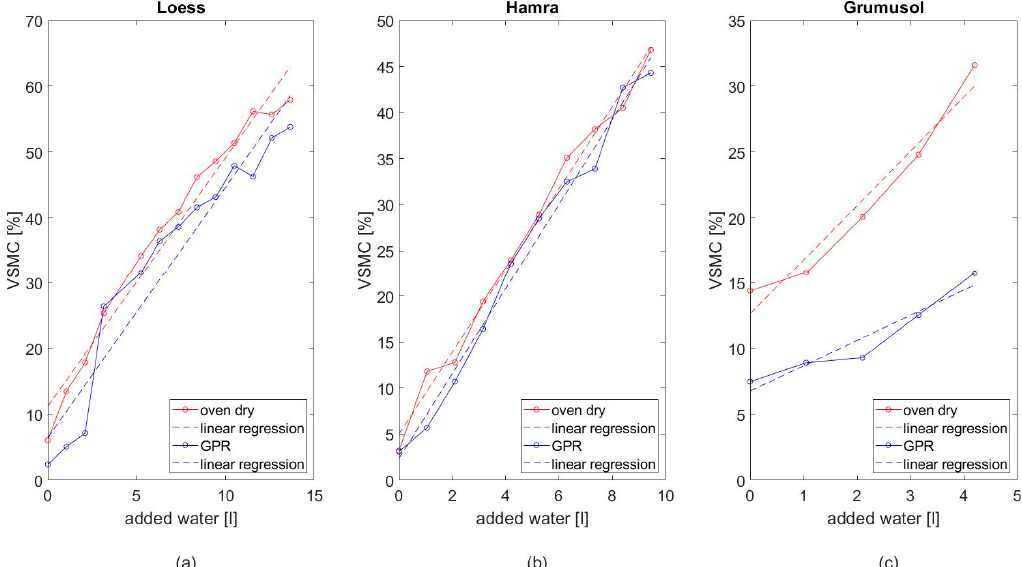
Figure 7. Soil calibration GPR measurements compared to a standard (oven-dried) sample with linear trend lines (by regression). ( a ) Loess; ( b ) hamra; ( c ) grumusol.